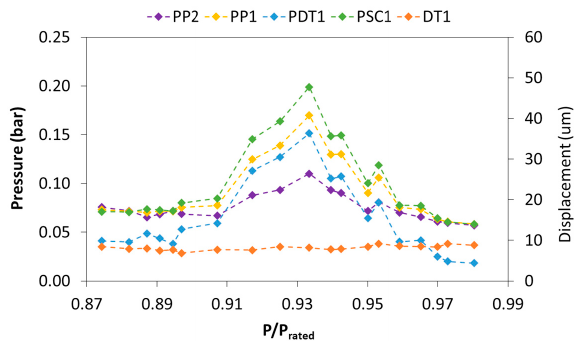
Figure 12. Time-frequency of the pressure in the draft tube (PDT1) and axial vibration in the thrust bearing (AGA1) for the high load operation.